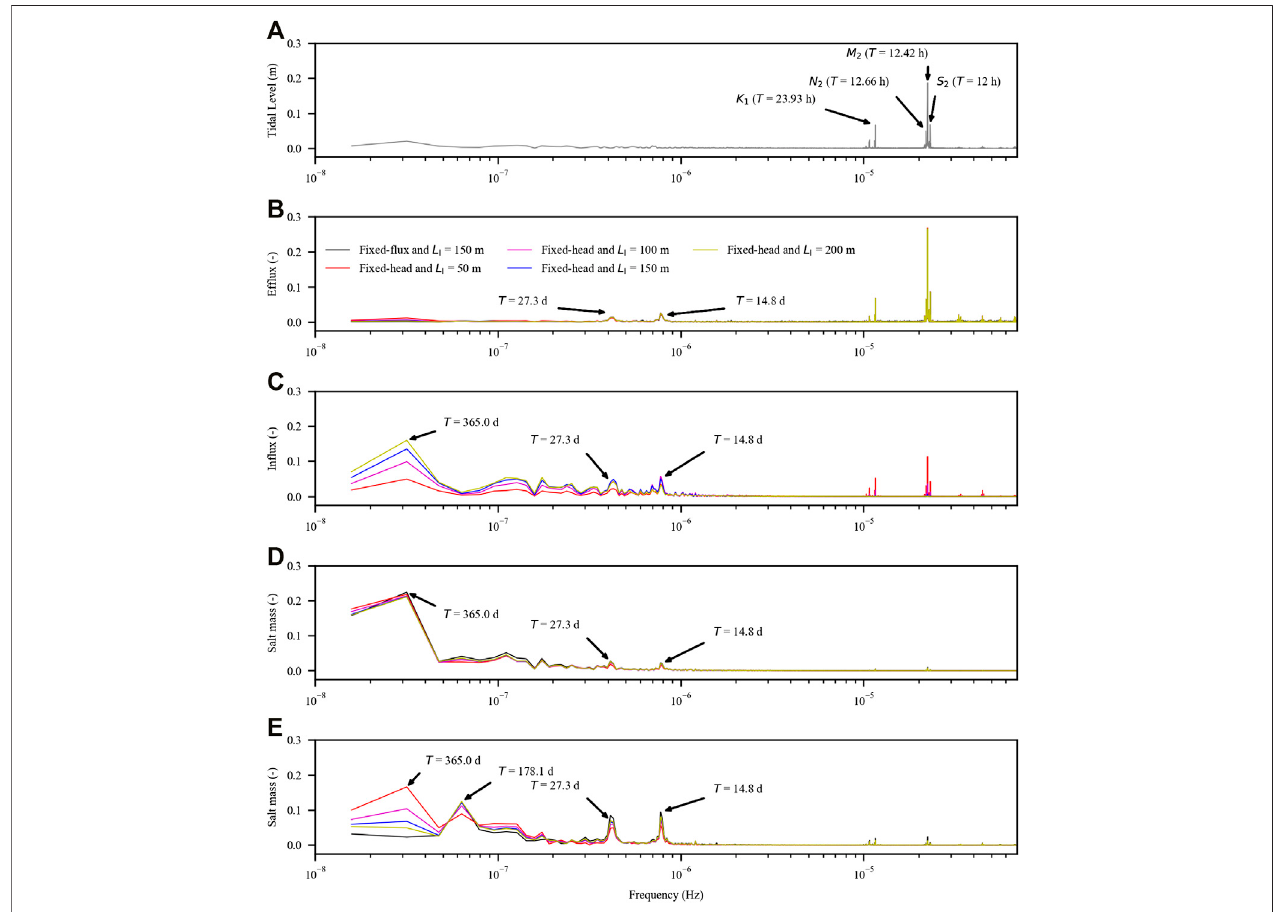
FIGURE 7 | Amplitude spectra of (A) tidal level variation, (B) submarine groundwater discharge (SGD), (C) inland freshwater input, (D) amount of salt stored in the saltwater wedge (SM SW ), and (E) amount of salt stored in the upper saline plume (SM USP ). The results are